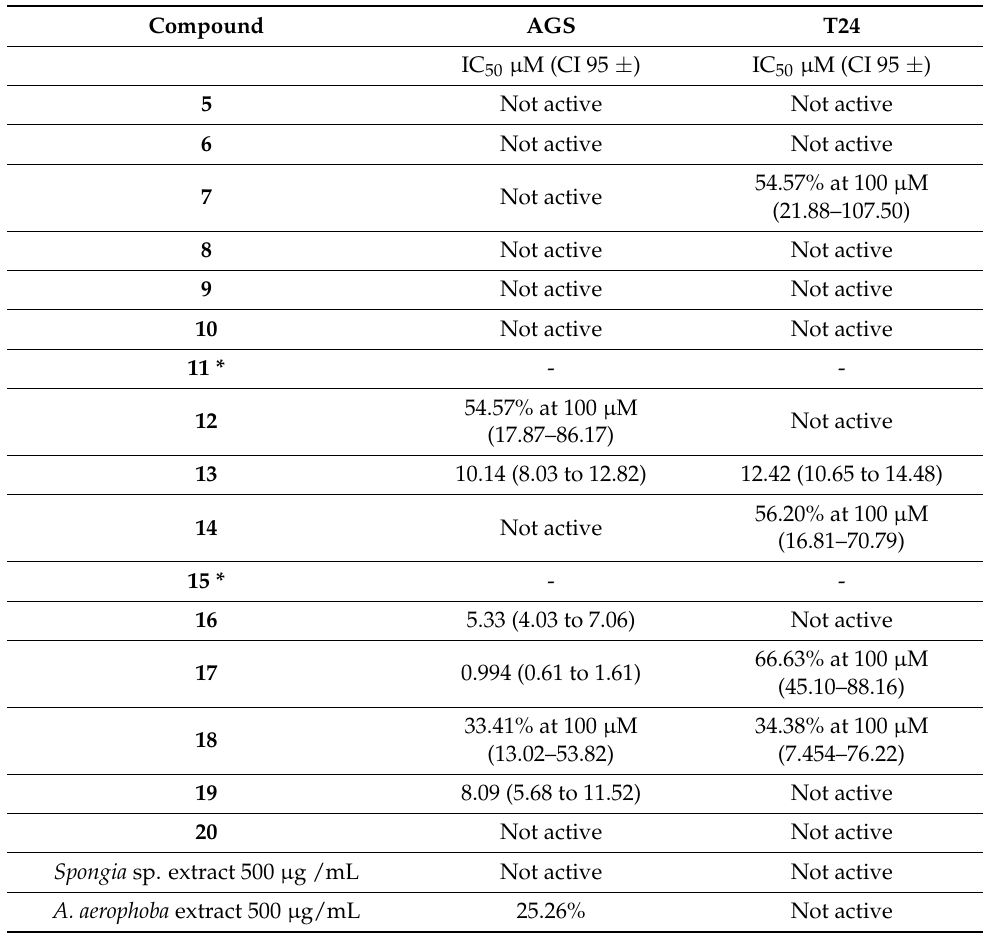
Table 4. Summary of all compounds and their IC 50 values of cell viability/% viability at 100 µ M. (95% confidence intervals in